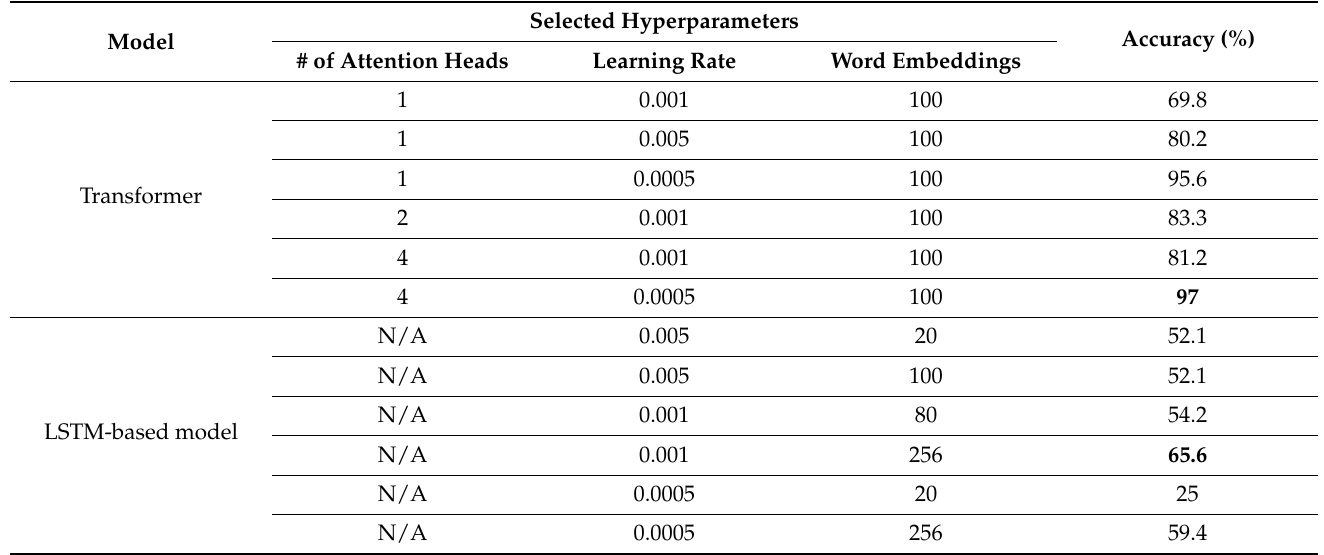
Table 3. Time cost (in seconds) for a single inference by the CNN and for generating one token by the video captioning models on both power modes of the Jetson nano board. Category